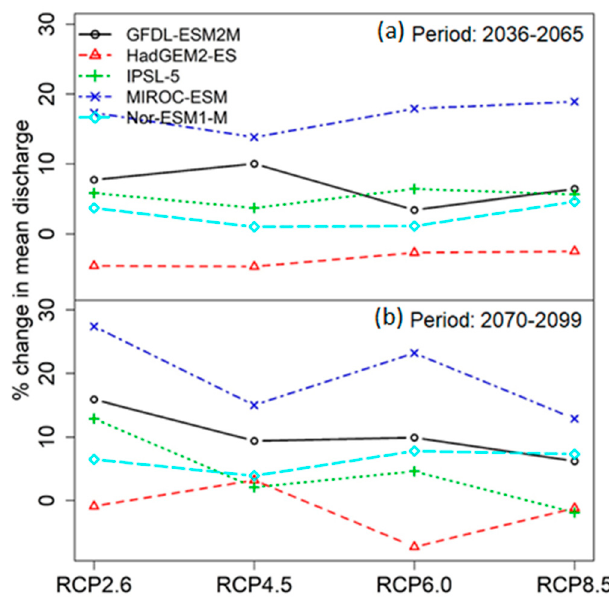
Figure 1. Percentage change in mean flow for the four Representative Concentration Pathways (RCPs) and five General Circulation Models (GCMs) for the two periods 2036–2065 ( a ) and 2070–2099 ( b ) are shown.